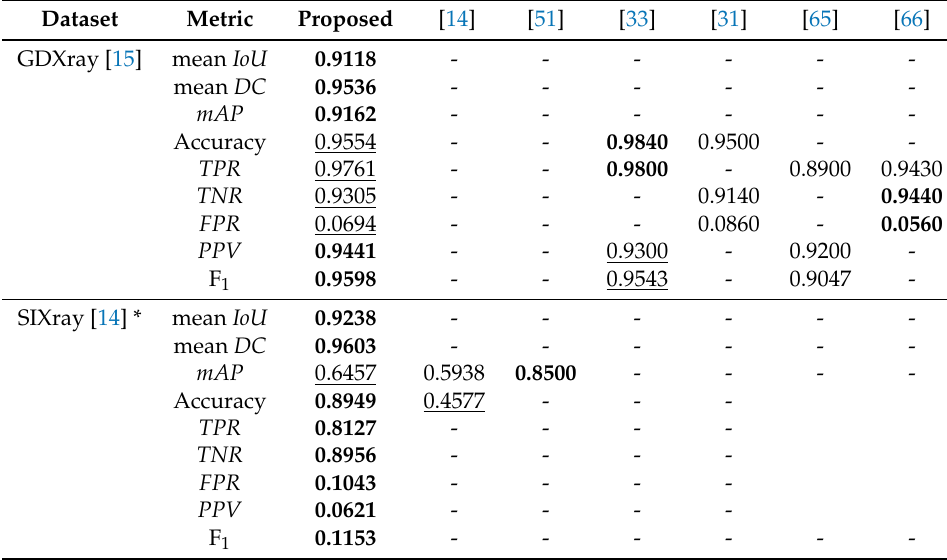
Table 4. Detection performance of the proposed framework on the GDXray [15] and the SIXray [14] dataset. Bold indicates the best performance while the second-best performance is underlined. ’-’ denotes that the metric is not computed.